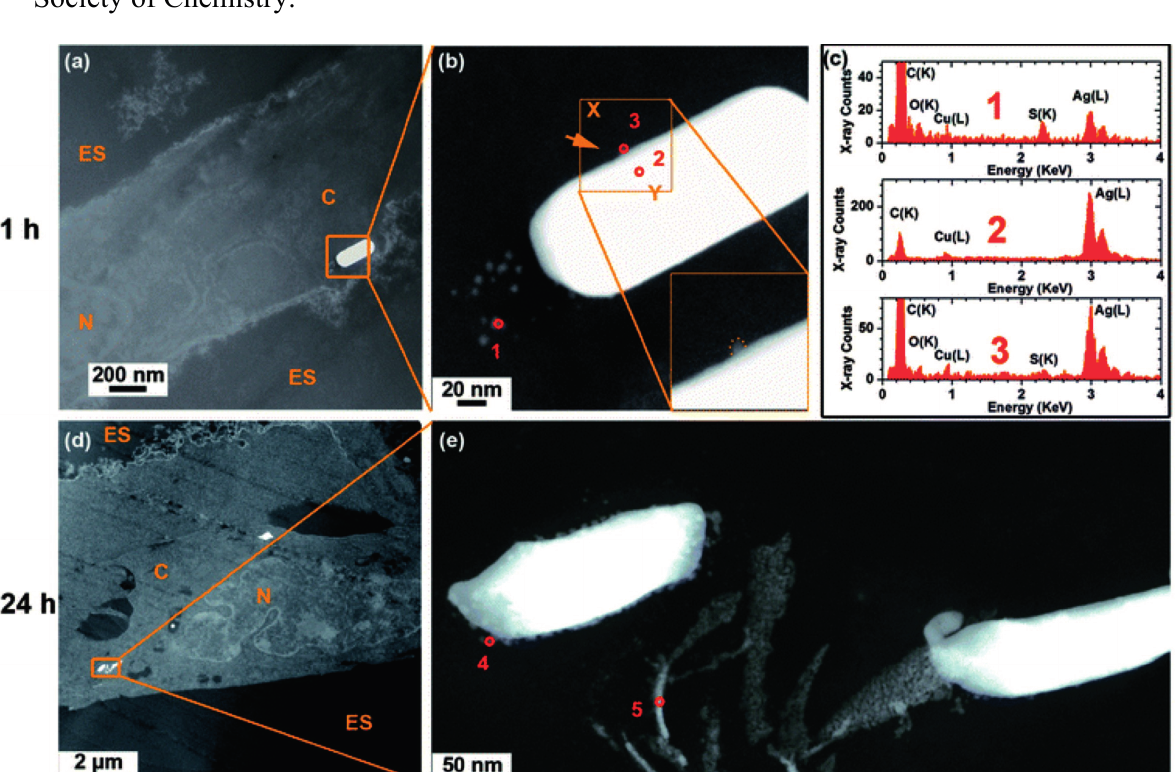
Figure 5. Changes in the morphology and chemistry of AgNWs as a function of time, after their uptake by TT1 epithelial cells at 1 h ( a – c ), 24 h ( d , e ) and seven days ( f – i ), following a pulsed exposure, using unstained cell sections. (ES = extracellular space; C = cytoplasm; N = nucleus) ( a ) HAADF-STEM image of an AgNW inside the cell cytoplasm showing particles surrounding the tip of the AgNW; ( b ) A corresponding higher resolution HAADF-STEM image depicts the boxed area in ( a ); The insert in ( b ) shows a higher magnification image of the AgNW edge; ( c ) STEM-EDX spectra taken from the corresponding areas 1–3 marked in ( b ); Ag(L) peaks and S(K) peaks were detected in the STEM-EDX spectra of these small particles, indicating the formation of Ag 2 S ( d , e ) HAADF-STEM images, where image ( e ) depicts the boxed area in ( d ), showing that dissolution and sulphidation of the AgNWs was more substantial after 24 h ( f – i ) HAADF-STEM images, where ( g ) depicts the boxed area in ( f ); ( h ) An HRTEM image of the boxed area in image ( g ). The particles had a lattice spacing of 0.29 nm, close to the mono-clinic structure of Ag 2 S (-112) ( i ) SAED pattern from the circled area in ( g ), using a selected area aperture size of ~130 nm. The interplanar spacings measured from the SAED patterns were consistent with bulk monoclinic Ag 2 S. Adapted with permission from [123]. Copyright 2013 The Royal Society of